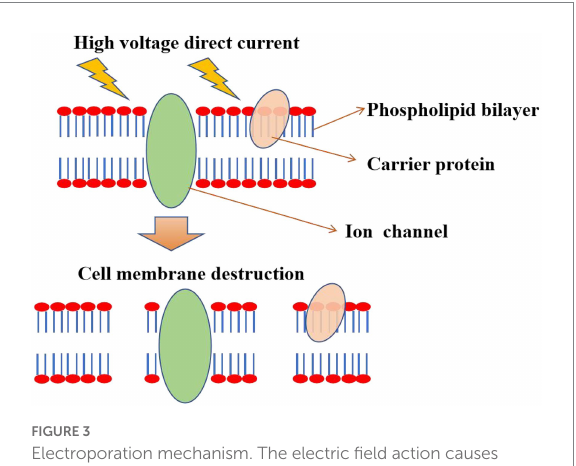
FIGURE 3 Electroporation mechanism. The electric field action causes destabilization of phospholipid bilayers and proteins, causing cell membrane perforation or rupture and cytoplasmic release, which results in microbial death.